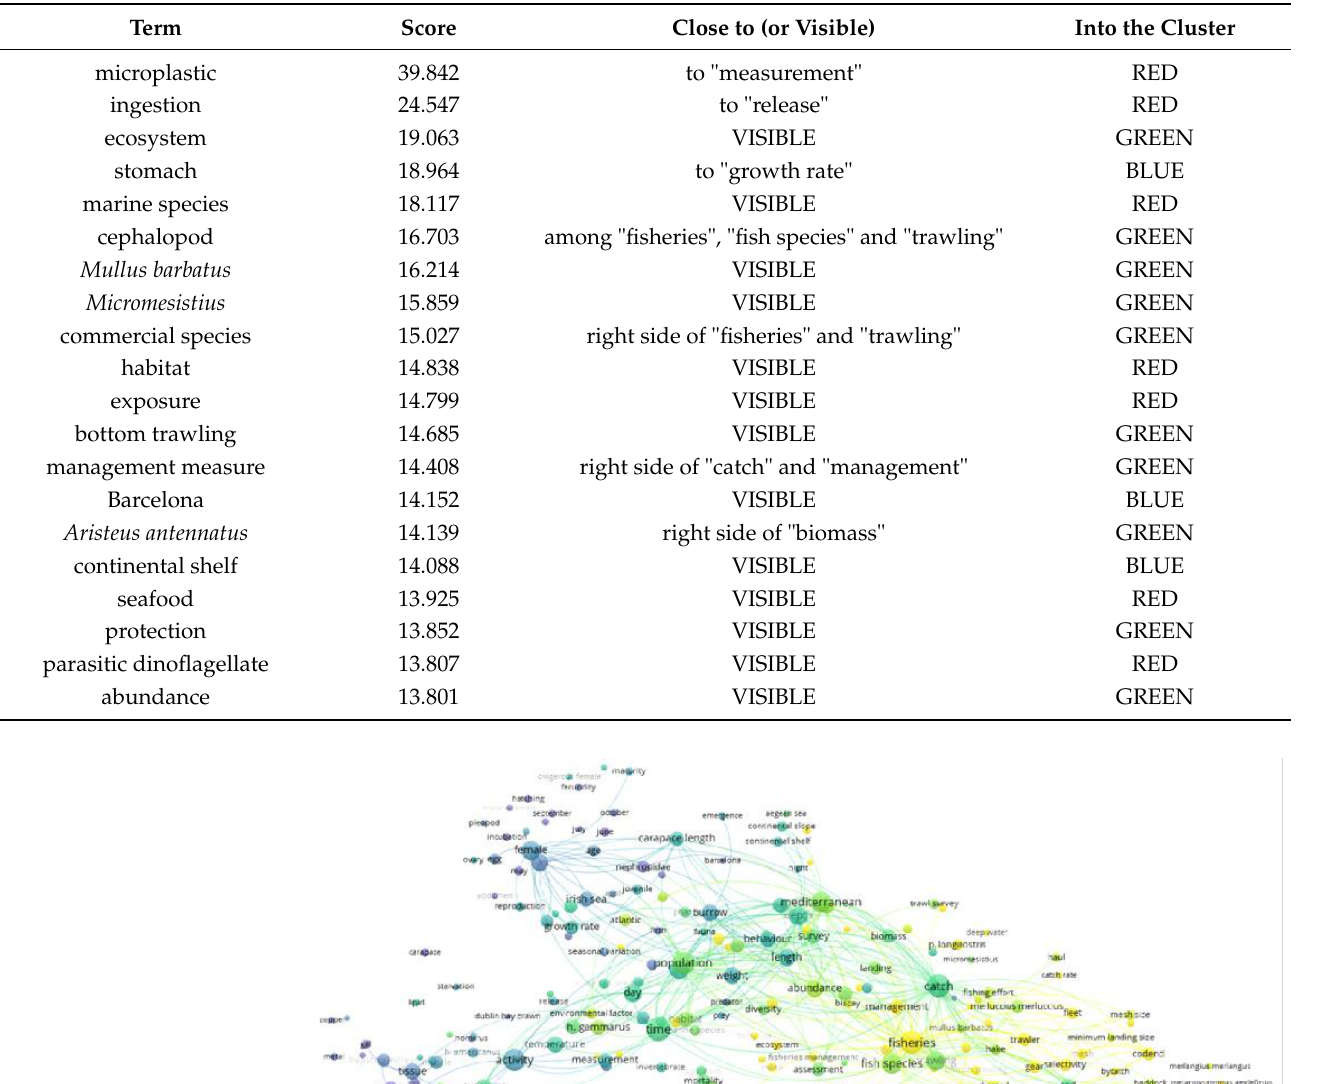
Table 2. The first 20 hot topic terms (i.e., with the highest citation score), sparse within the term score (average normalized citation) map of Figure 3. Some of those terms are not visible in the map due to labels overlapping, and therefore their positioning has been identified close to other visible terms of reference, with an indication of the belonging cluster (as per Figure 2).